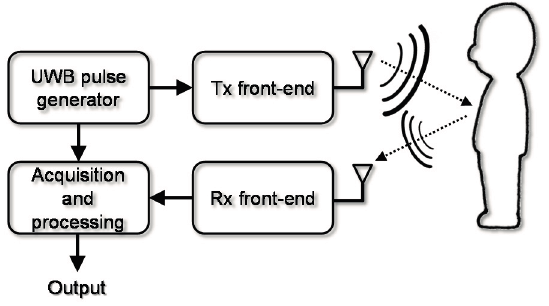
Figure 1. Block diagram of the considered sensing